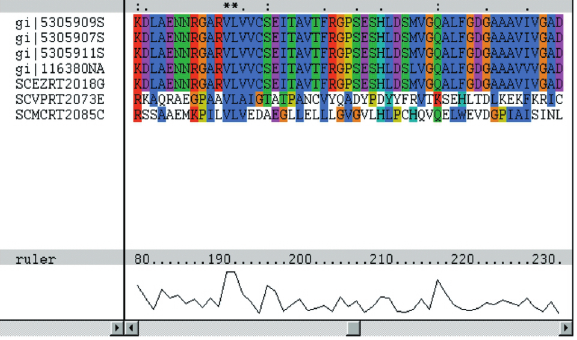
Figure 2 - Multiple alignment of full length sugarcane sequences and chalcone synthase (CHS) genes from sorghum and maize. Sorghum (gi:5005907; gi:5005909; gi:5005911) and maize (gi:116380).